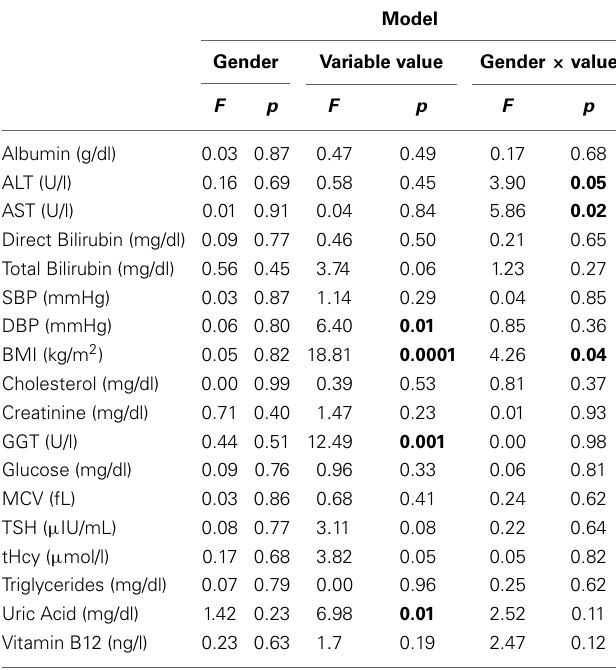
Table 3 | ANCOVA results for BrainAGE scores and health and lifestyle